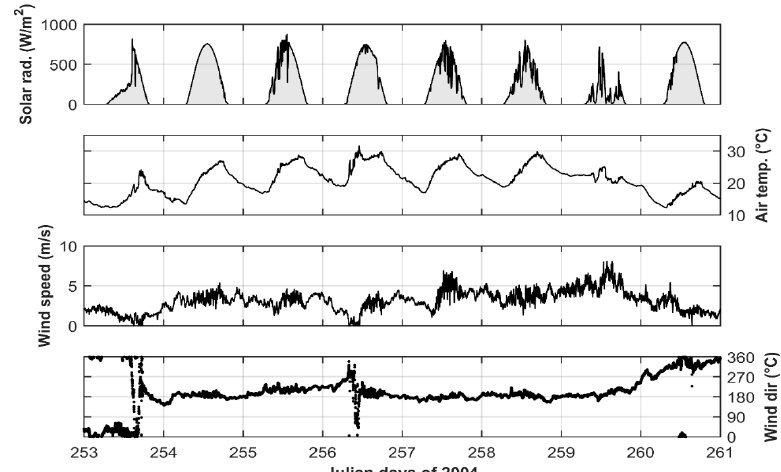
Figure 2. Measured meteorological data during 253–261 Julian day. Solar radiation was measured at the Atmospheric and Ocean Space Science Rooftop station, wind speed and direction were measured at station W8 in Figure 1, while air temperature was measured at central location CT in Figure 1.